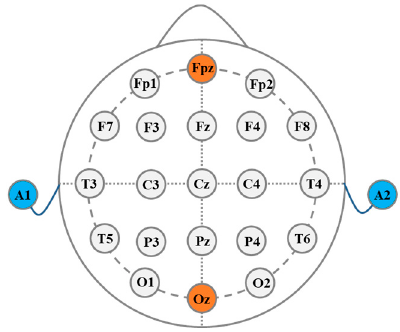
Figure 5. Schematic diagram of the electrode position.